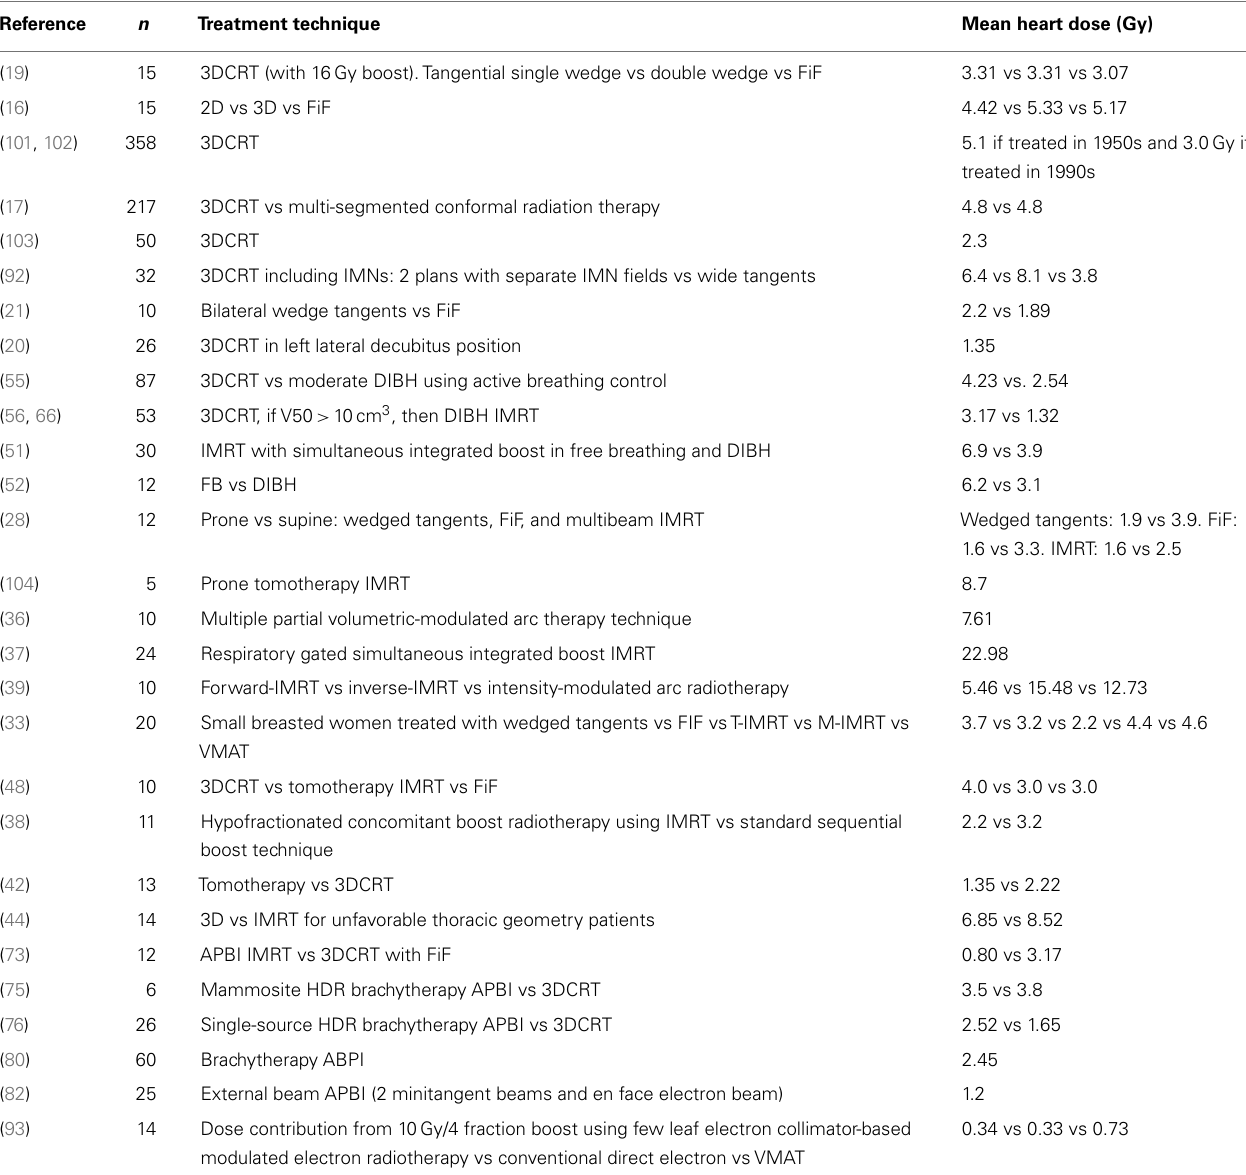
Table 1 | Summary of studies evaluating mean heart dose